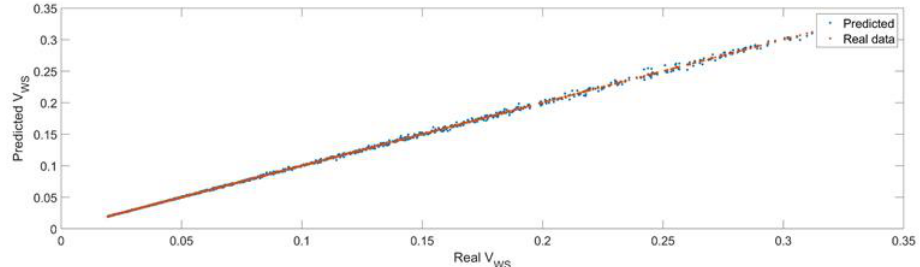
Figure 31. Convergence of the neural network for workspace (log scale).